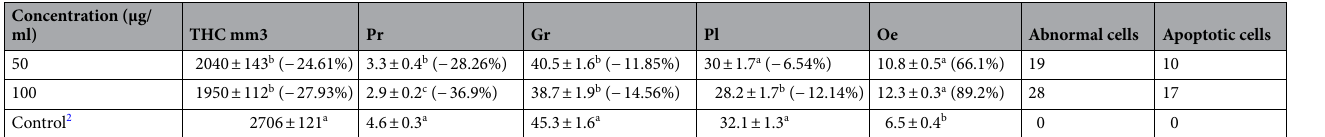
Table 2. Effects of ZnO-NPs on the total and different hemocyte count in 5th larval instar of B. mori. Each value presents the mean ± SE. THC total hemocyte count, Pr prohaemocyte, Gr granulocyte, Pl plasmatocyte, Oe oenocyte. Means at each Colum followed by the same letter are not significantly different at 0.01. Values in parentheses indicate the percentage decreased under the control.